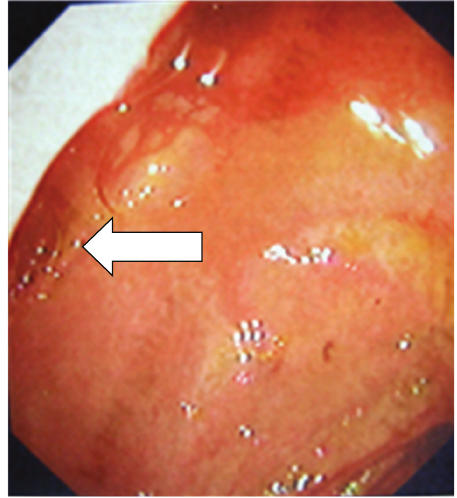
Figure 8: A cholecystoduodenal fistula orifice noticed in the superior duodenal wall